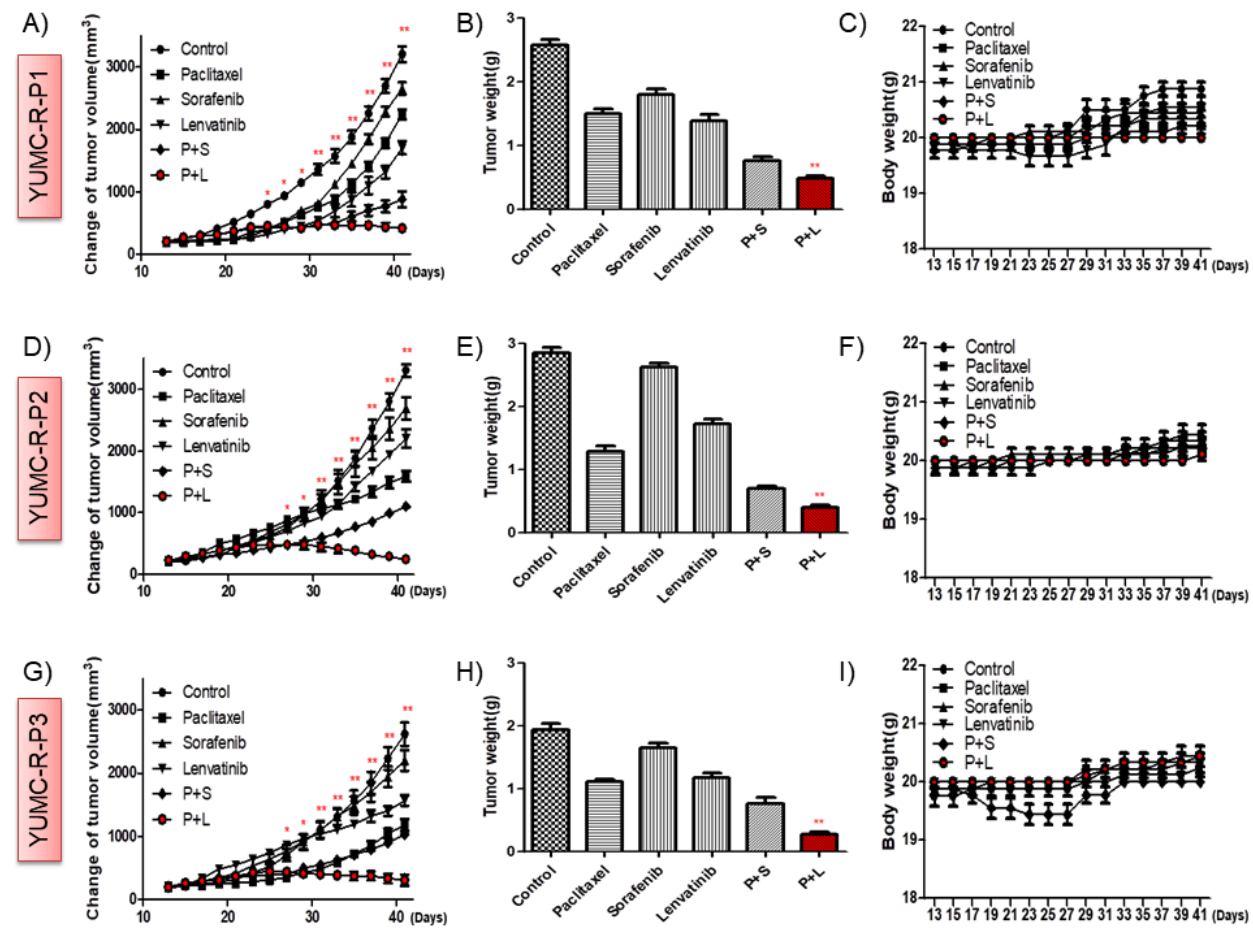
Figure 5. Combination of paclitaxel and lenvatinib produced the highest tumor shrinkage in patient-derived anti-cancer drug (paclitaxel or sorafenib)-resistant papillary thyroid cancer (PTC) cells, YUMC-R-P1, YUMC-R-P2, and YUMC-R-P3 xenografts in vivo. ( A , D , G ), Change in tumor volume, ( B , E , H ), the dissected tumor weight, and ( C , F , I ), change in whole body weight. Paclitxel, sorafenib, and lenvatinib alone had no significant effect on the mouse body weight. * p < 0.05 and ** p < 0.01, compared with control.